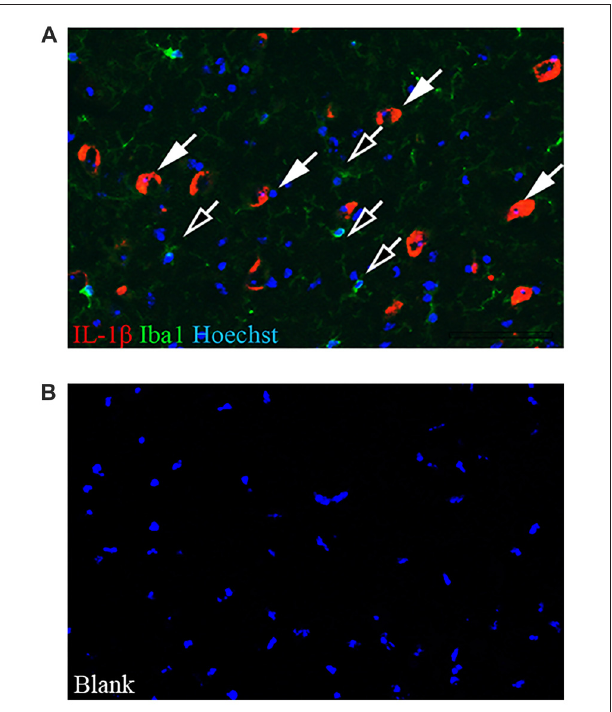
FIGURE 4 | IL-1 β localization in the SN. (A) Representative image of IL-1 β (red) and Iba1 (green) immunofluorescence with Hoechst (blue) staining in the SN of 13-month-old c-rel − / − mice. Closed arrows highlight IL-1 β -positive cells. Open arrows highlight Iba1-positive cells. The image is representative of five sections from each animal ( n = 3). (B) Blank control. Abbreviations: SN, substantia nigra. Scale bar: in (A) = 100 µ m for (A,B)